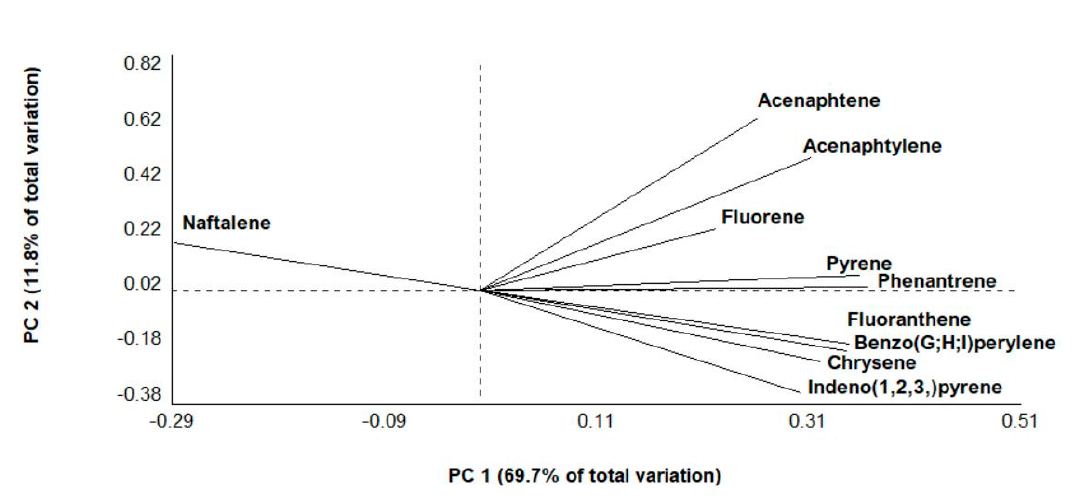
Figure 3. Principal component analysis (PCA) considering the relative higher abundance of the PAHs, grouped according to the